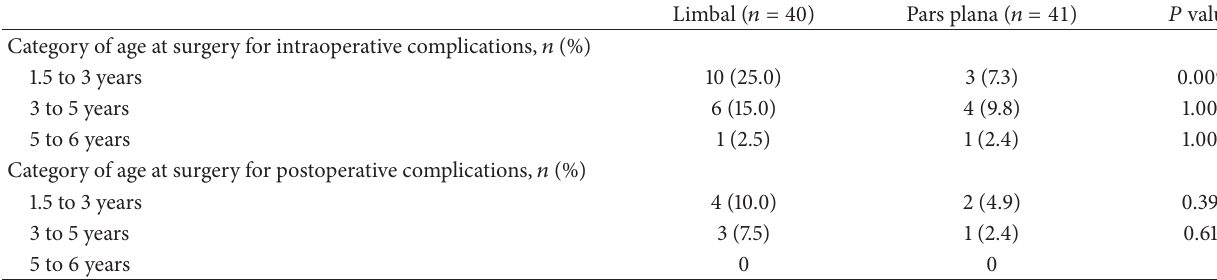
Table 4: Age distribution of eyes with intraoperative